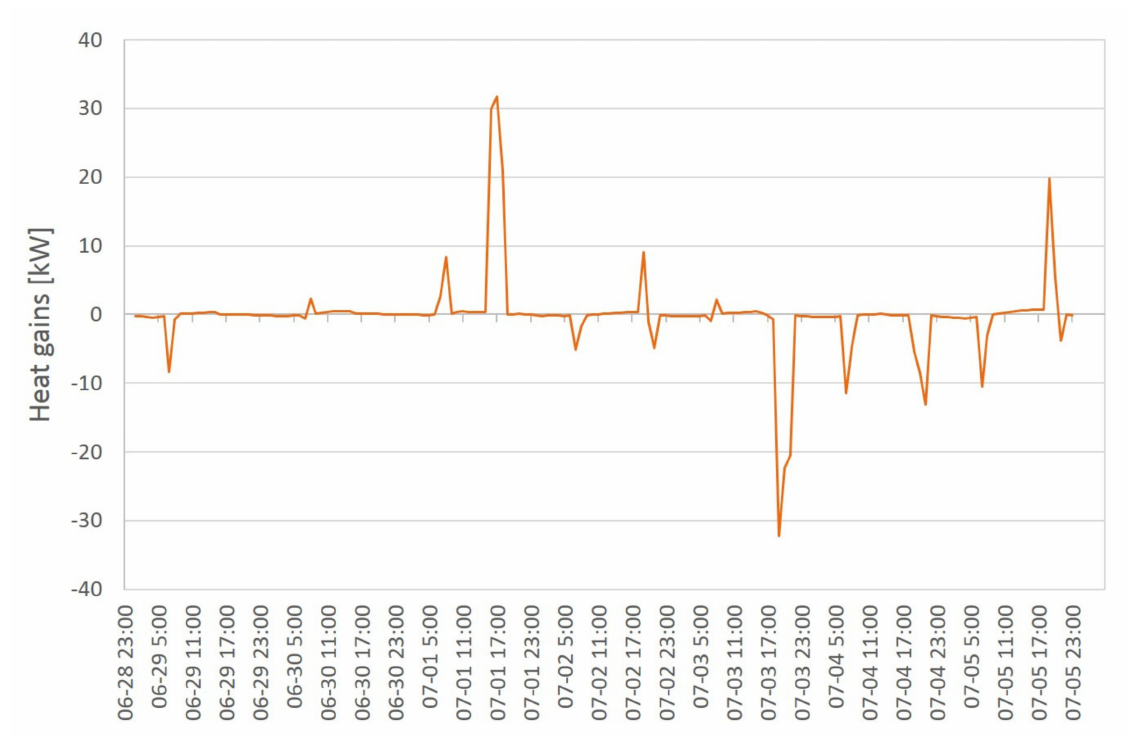
Figure 12. Distribution of heat gains from outdoor air for the selected